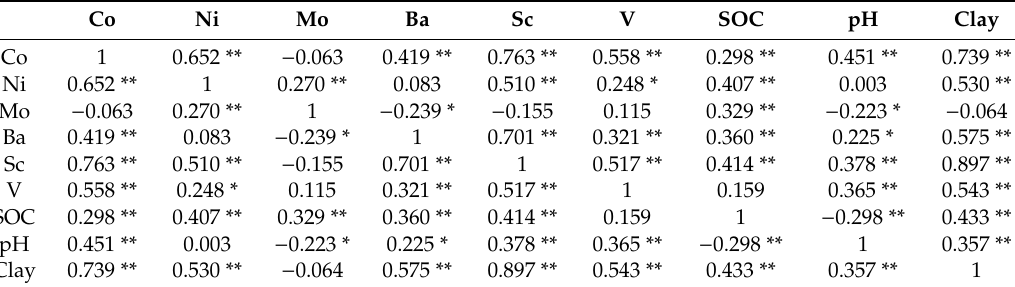
Table 3. Correlation analysis between heavy metals and soil properties.